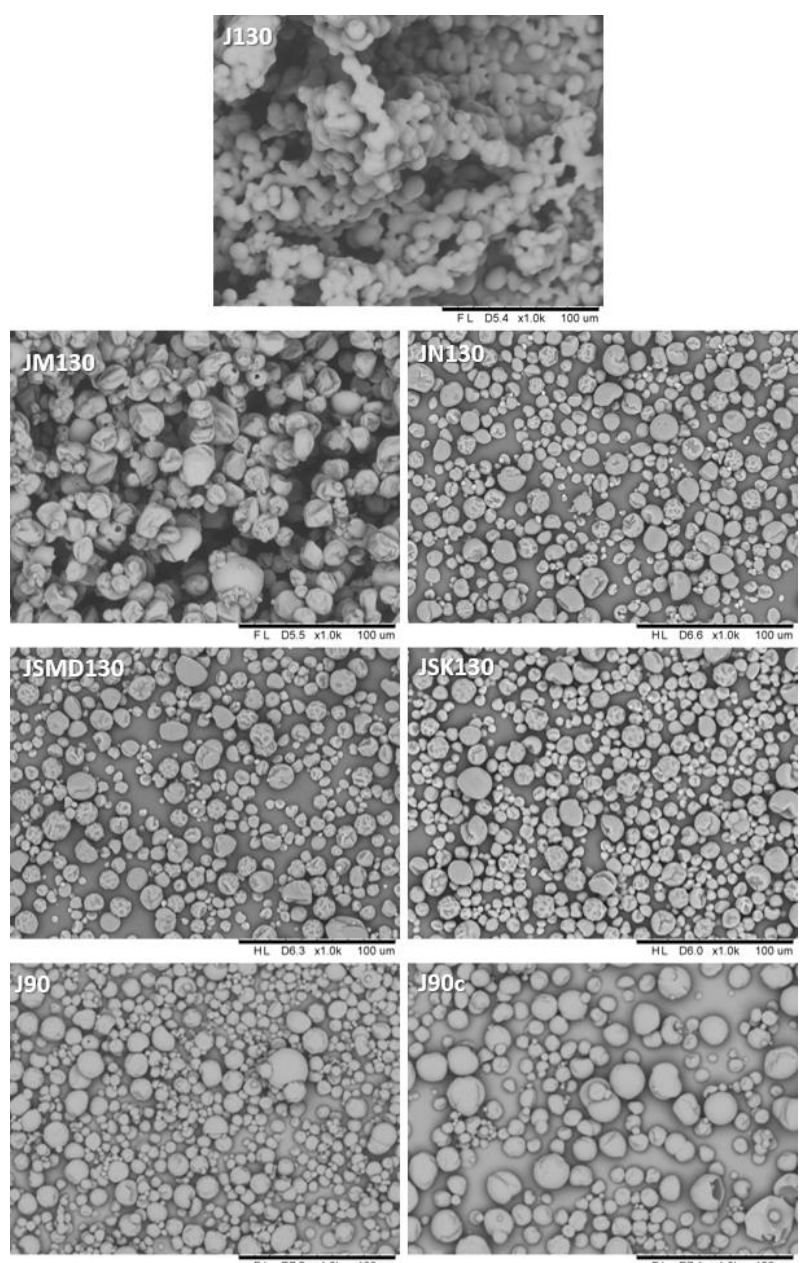
Figure 1. SEM microphotographs of cloudy beetroot powders (abbreviations of variants explained in Table 1).